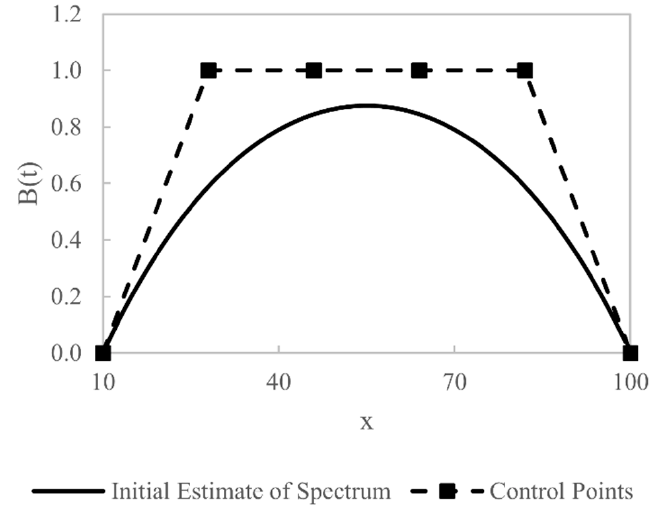
Figure 4. Plot of the initial estimate of (cid:1849)((cid:1831)) using a Bézier curve and its control